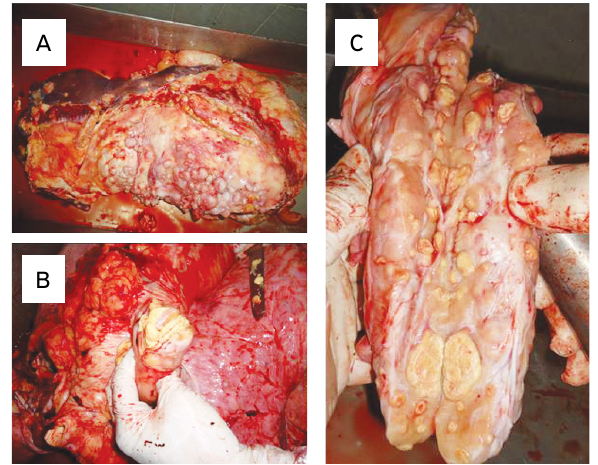
Figura 1. Lesões nodulares típicas de tuberculose em órgãos de bovinos positivos no teste cervical comparativo.